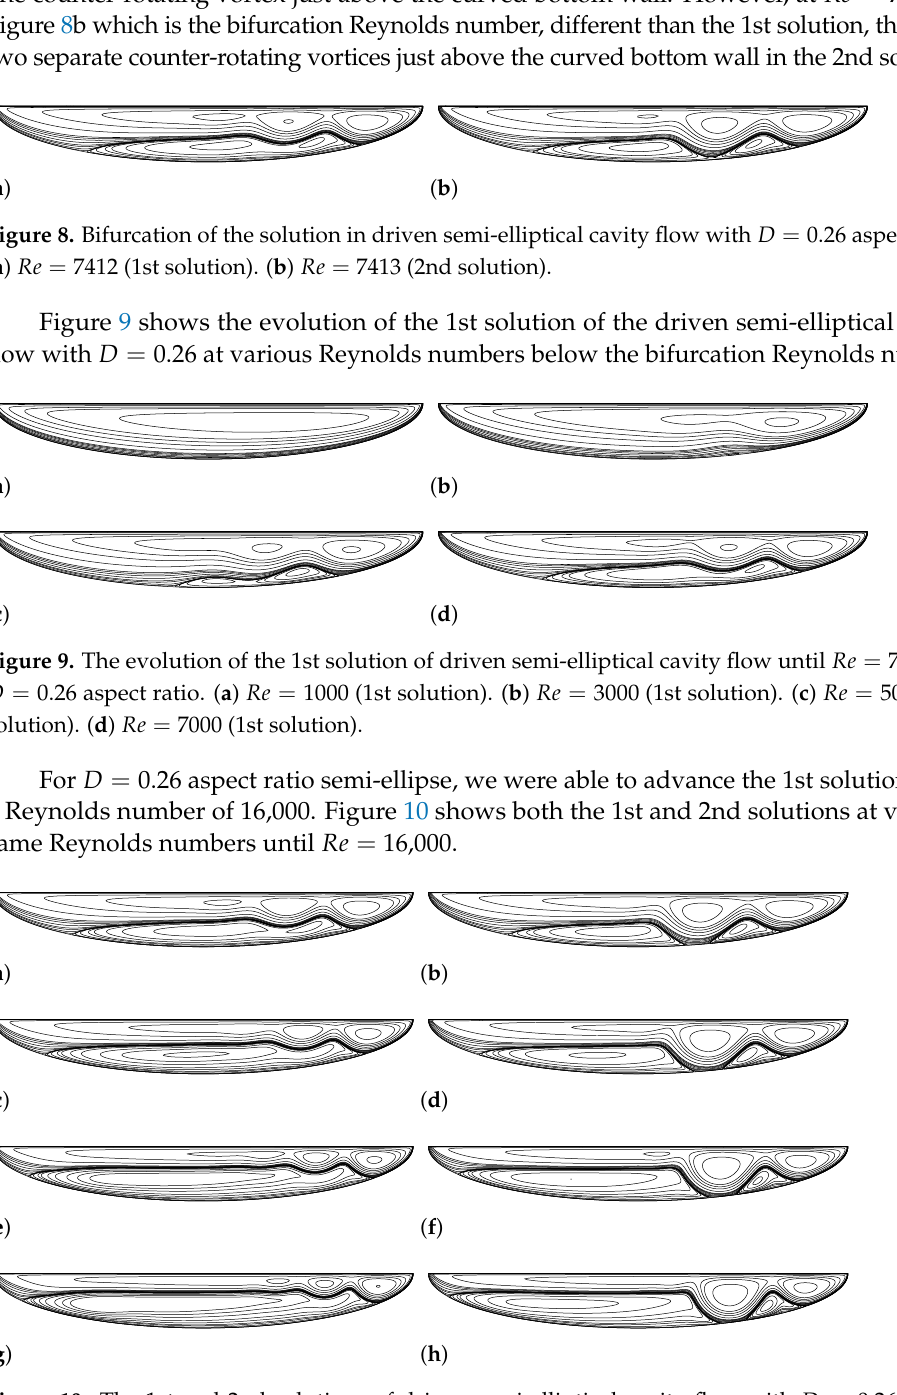
Figure 10. The 1st and 2nd solutions of driven semi-elliptical cavity flow with D = 0.26 aspect ratio at various same Reynolds numbers. ( a ) Re = 8000 (1st solution). ( b ) Re = 8000 (2nd solution). ( c ) Re = 10,000 (1st solution). ( d ) Re = 10,000 (2nd solution). ( e ) Re = 13,000 (1st solution). ( f ) Re = 13,000 (2nd solution). ( g ) Re = 16,000 (1st solution). ( h ) Re = 16,000 (2nd